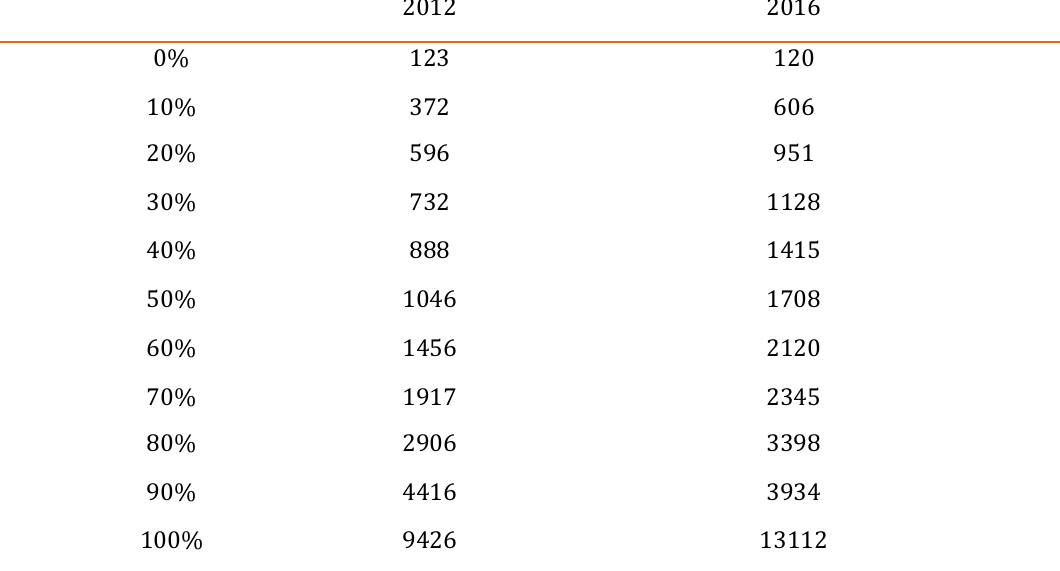
Table 02. Distribution of number of words per set of programs in